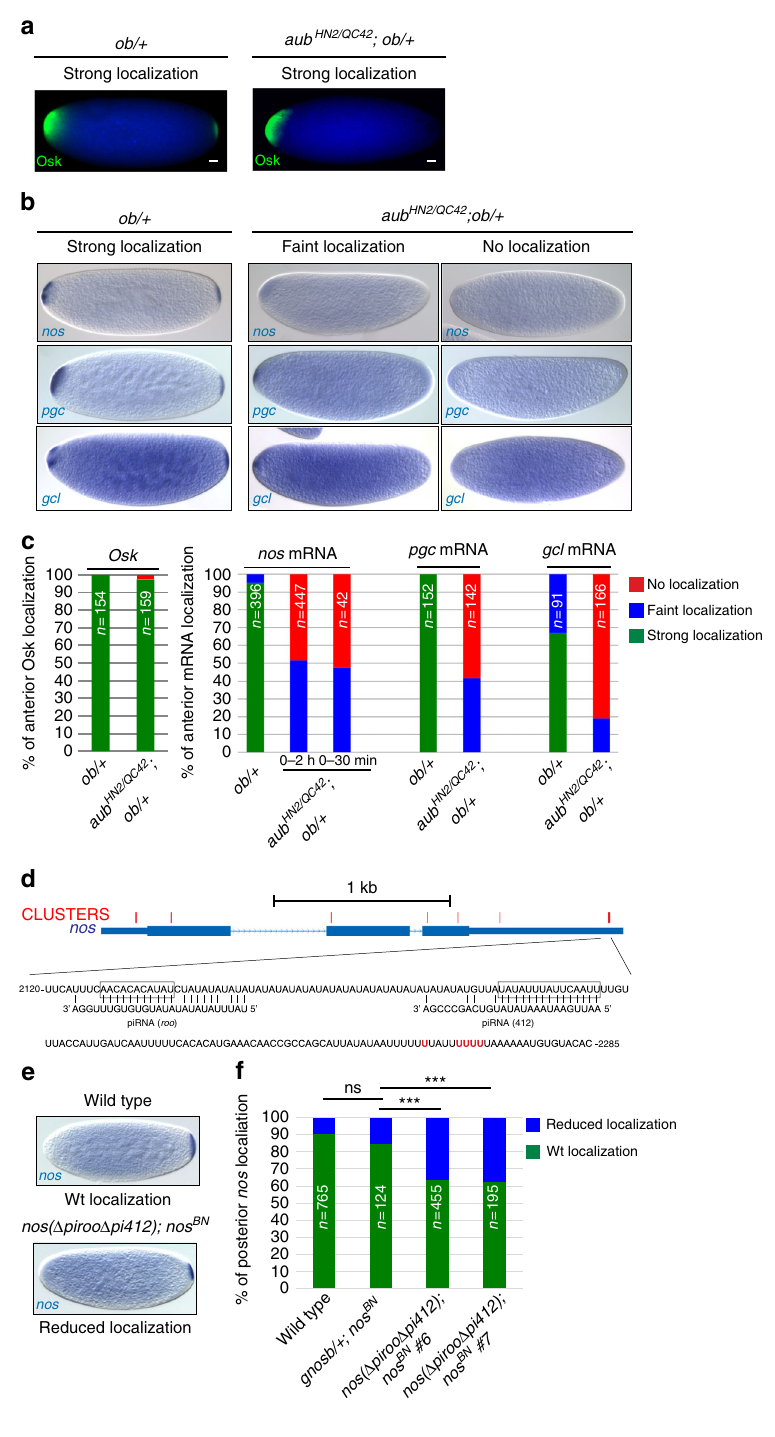
Fig. 2 Role of Aub and piRNAs in germ cell mRNA localization to the germ plasm. a Immunostaining with anti-Osk of osk-bcd3 ′ UTR ( ob ) embryos in wild- type or aub mutant backgrounds. The DAPI staining background (blue) shows the bulk of the embryo. Scale bars: 30 μ m. b In situ hybrydization of 0 – 2 h ob/ + embryos either in wild-type or aub mutant backgrounds, with nos , pgc and gcl RNA probes. c Quanti fi cation of Osk and mRNA localization shown in a , b , respectively. 0 – 30min-embryos were also quanti fi ed for nos mRNA. d Schematic representation of nos mRNA and base-pairing with piRNAs. Thin boxes are 5 ′ - and 3 ′ -UTRs, lines are introns, and thick boxes are exons. Crosslink clusters from Aub-iCLIP are indicated in red. The sequence of the region with the strongest crosslink sites is shown. Base-pairing with representative piRNAs from roo and 412 TEs is shown; the deletions overlaping the piRNA target sites in the nos ( Δ piroo Δ pi412 ) transgene are boxed 15 . Aub-crosslinked nt are in red. e nos mRNA in situ hybrydization of 0 – 2 h-embryos from wild- type and nos ( Δ piroo Δ pi412 ); nos BN females. The nos BN mutant does not produce nos mRNA in the embryo. f Quanti fi cation of nos mRNA posterior localization as shown in e , for wild-type embryos, nos BN embryos bearing the wild-type genomic nos ( gnosb ) transgene, and nos BN embryos bearing the nos ( Δ piroo Δ pi412 ) transgene from two independent stocks. ns: non-signi fi cant, *** p < 0.001, using χ 2